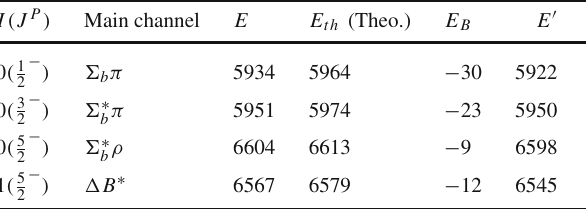
Table 17 Possible pentaquarks of qqq ¯ qb system (unit: MeV)